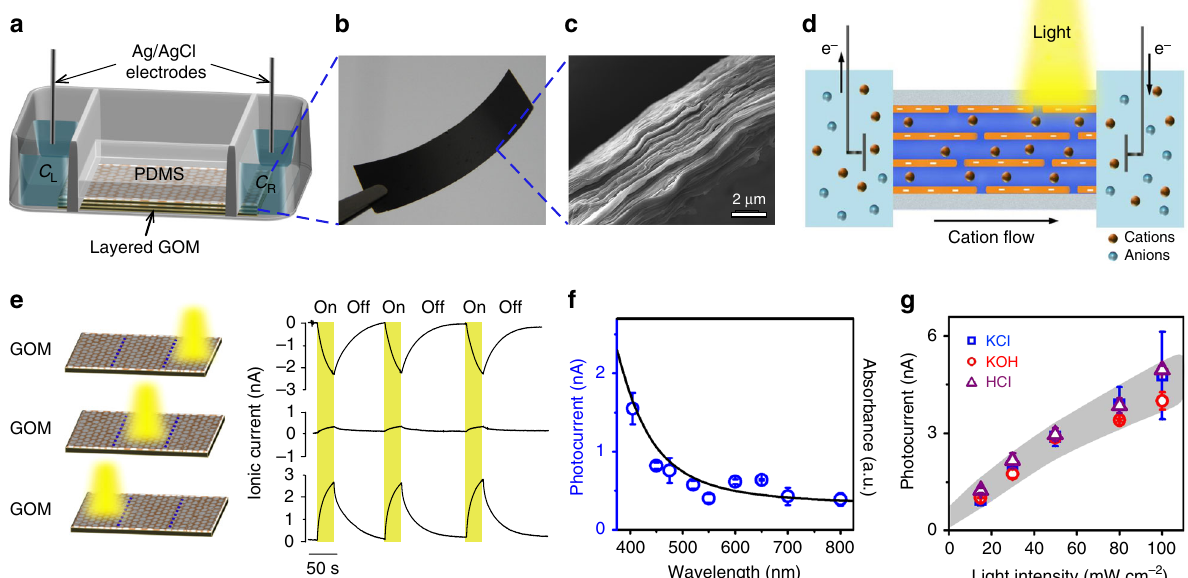
Fig. 1 Photo-induced ion transport through GOM. a Scheme of the device. b A photograph of the GO strip. c SEM image on the cross-section shows a layered structure. d Schematic illustration of the generation of net ionic fl ow through the GOM upon asymmetric light illumination. e Time traces of the photocurrent. Light illumination (100 mW cm − 2 , 30 s duration) was applied separately on three different positions (right, middle, or left). f UV – vis absorption spectrum of GO dispersion (solid curve), and photocurrent at each wavelength (open circles). g Similar photo-response is found in KCl, KOH, or HCl solutions. The electrolyte concentrations were 1 μ M. Error bars denote standard